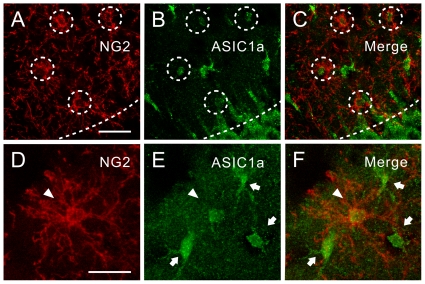
Hippocampal NG2 cells express ASIC1a subunit proteins.(A) An example of images showing NG2 immunoreactivity of CA1 stratum radiatum. Dashed circles denote NG2 immunoreactive cells. Dashed lines demarcate the border between stratum radiatum and stratum pyramidale. Scale bar, 30 µm. (B) The same slice showing ASIC1a immunoreactivity of CA1 stratum radiatum. (C) Images of (A) and (B) are superimposed. (D) A magnified NG2-immunoreactive cell (arrowhead) in the stratum radiatum. Scale bar, 20 µm. (E) Immunostaining of the same cell (arrowhead) for ASIC1a subunit protein. Arrows, NG2-negative but ASIC1a-positive cells. (F) Images of (D) and (E) are superimposed.